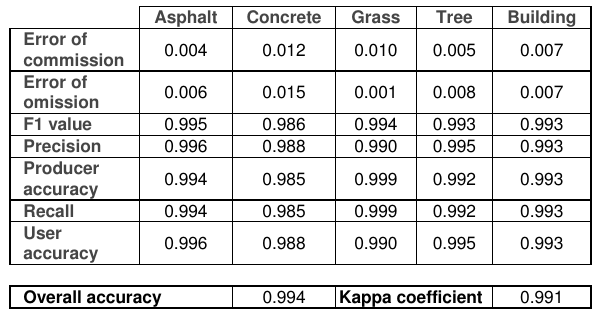
Table 1. Accuracy metrics for the Softmax Regression classifier.